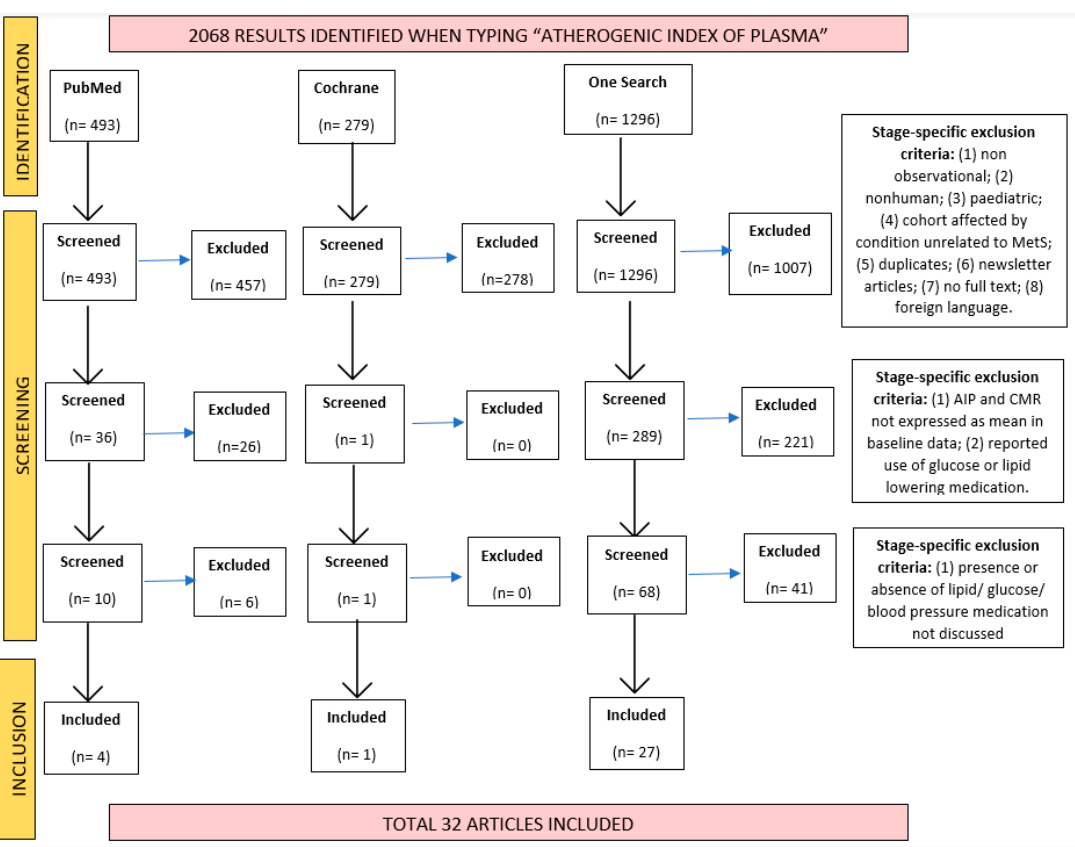
Figure 1. PRISMA flowchart showing the studies identified, screened and included in the current systematic review, and the exclusion criteria applied at each of these stages. Table 2. Quality assessment of all 30 studies included using the Newcastle-Ottawa quality assess- ment scales for case–control studies and cross-sectional studies (adapted) [27–55].